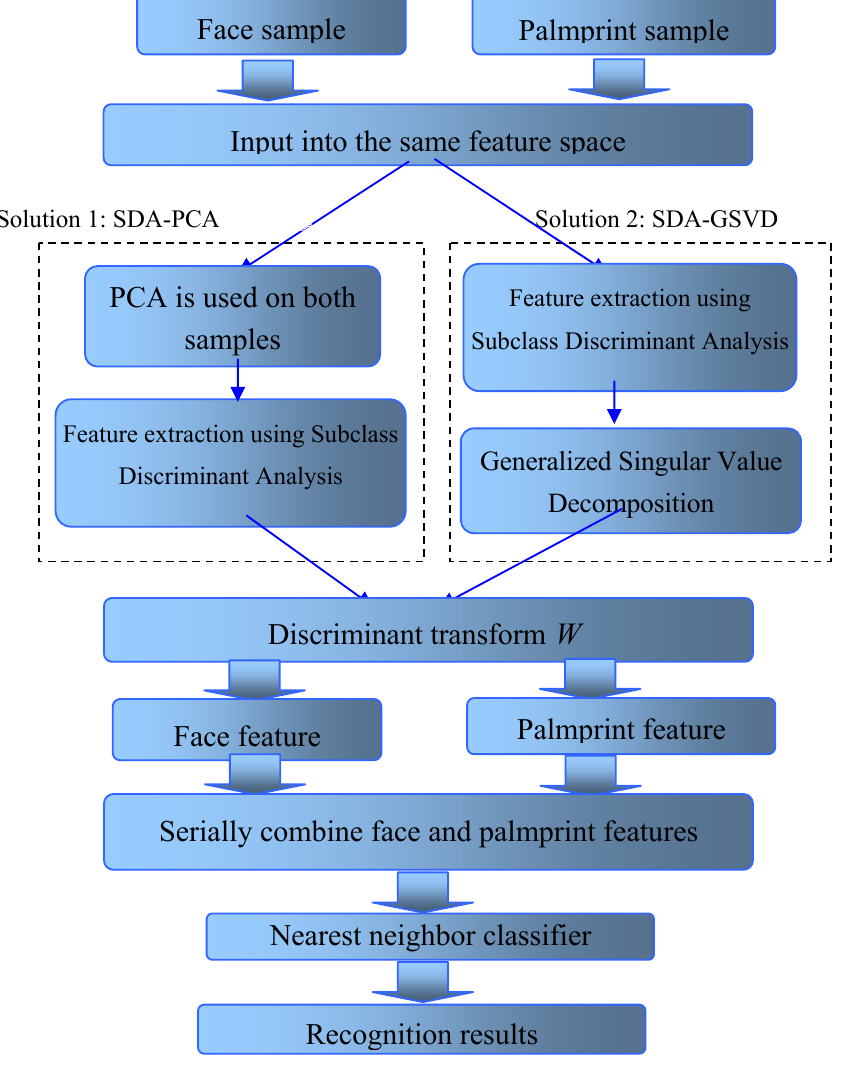
Figure 2. The complete procedures of SDA based multimodal feature